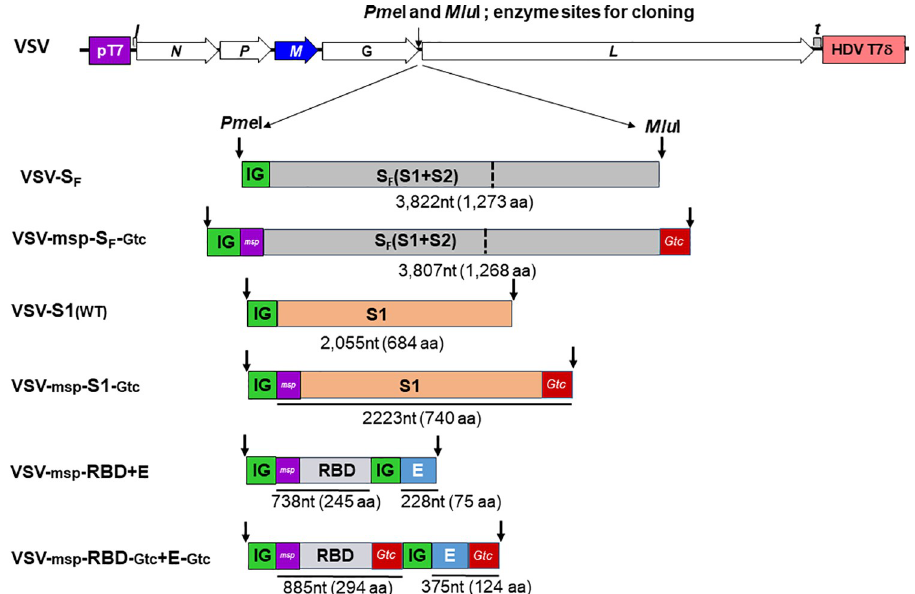
Fig 1. Construction of recombinant rVSV Ind and rVSV NJ with S F , S1, and RBD+E genes of SARS-CoV-2 with and without honeybee msp and VSV Gtc . Codon-optimized full-length Spike protein gene (S F ), S1 subunit gene and the receptor-binding domain (RBD) plus envelope protein genes of SARS-CoV-2 with and without 21 amino acids honeybee melittin signal peptide [(msp) NH 2 -MKFLVNVALVFMVVYISYIYA-COOH] [24] gene in the purple box, and 49 amino acids VSV G protein transmembrane domain and cytoplasmic tail [(Gtc) NH 2 -SSIASFFFIIGLIIGLFL VLRVGIYLCIKLKHTKKRQIYTDIEMNRLGK-COOH] gene in the red box were inserted into the G and L gene junction of rVSV Ind and rVSV NJ . In addition, 25- nucleotides-long VSV intergenic junctions (5 ´-CATATGAAAAAAACTAACAGATATC-3´), in the green box, were inserted between genes to provide transcription termination, polyadenylation and the transcription reinitiation sequences. Recombinant viruses were rescued by VSV reverse genetics [20]. pT7: Bacteriophage T7 promoter for DNA-dependent RNA polymerase. N : VSV Nucleocapsid Protein gene. P : VSV Phosphoprotein gene. M : VSV Matrix protein gene. G : VSV Glycoprotein gene. L : VSV Large protein, RNA-dependent RNA polymerase gene. l : Leader region in the 3´-end of the VSV genome. t : Trailer region in the 5´-end of the VSV genome. HDV: Hepatitis delta virus ribozyme encoding sequences. T7 δ : Bacteriophage T7 transcriptional terminator sequences. nt: nucleotides. aa: amino acids.